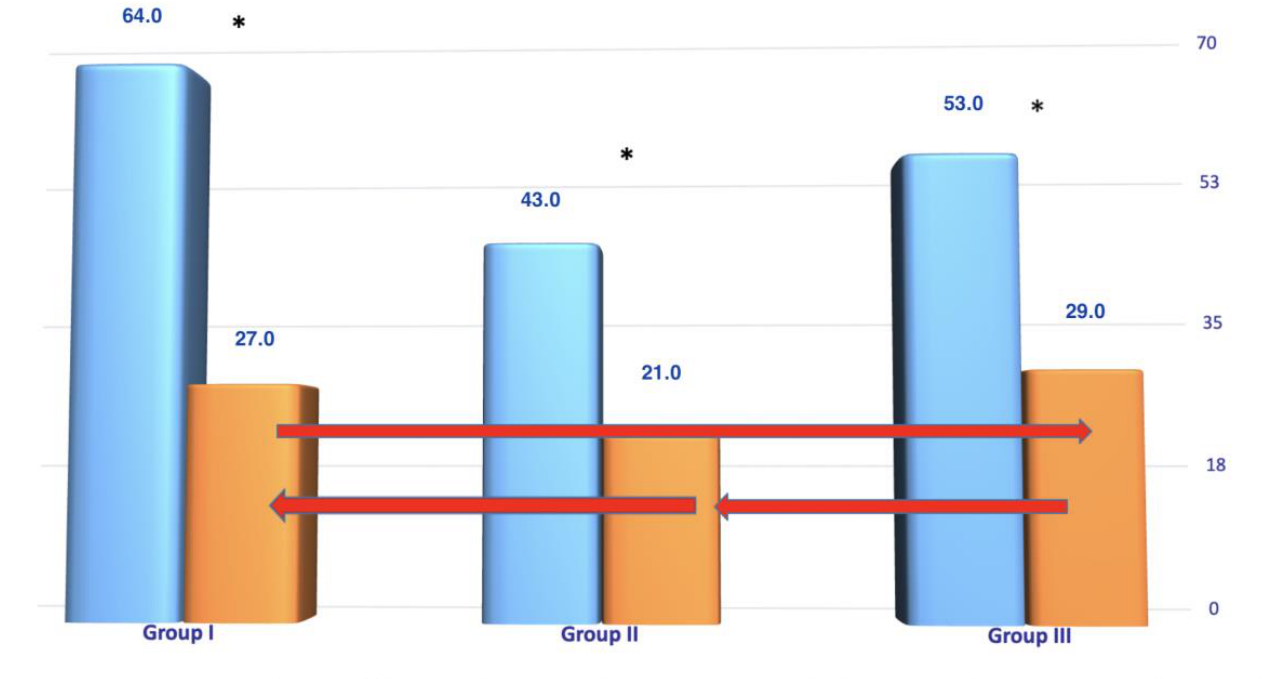
Figure 2. The magnitude of pain intensity on the Laitinen Scale in patients from all groups collected together before and after treatment (results in points). *—statistically significant.